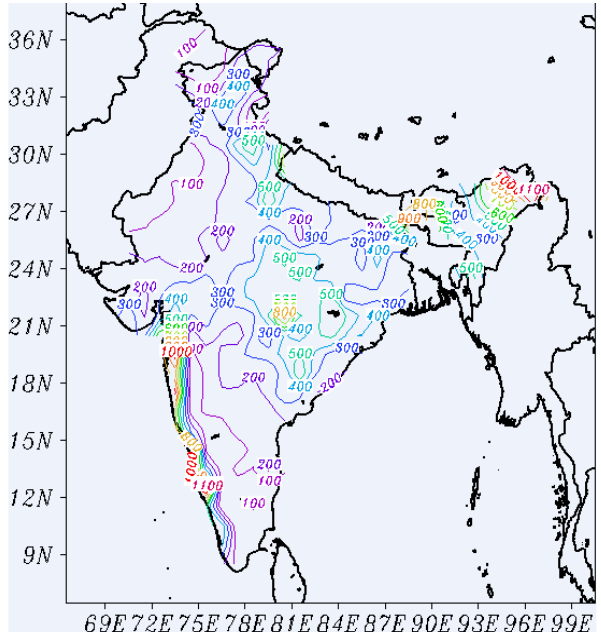
Fig. 12. IMD rainfall (mm) 2002 (JJAS).